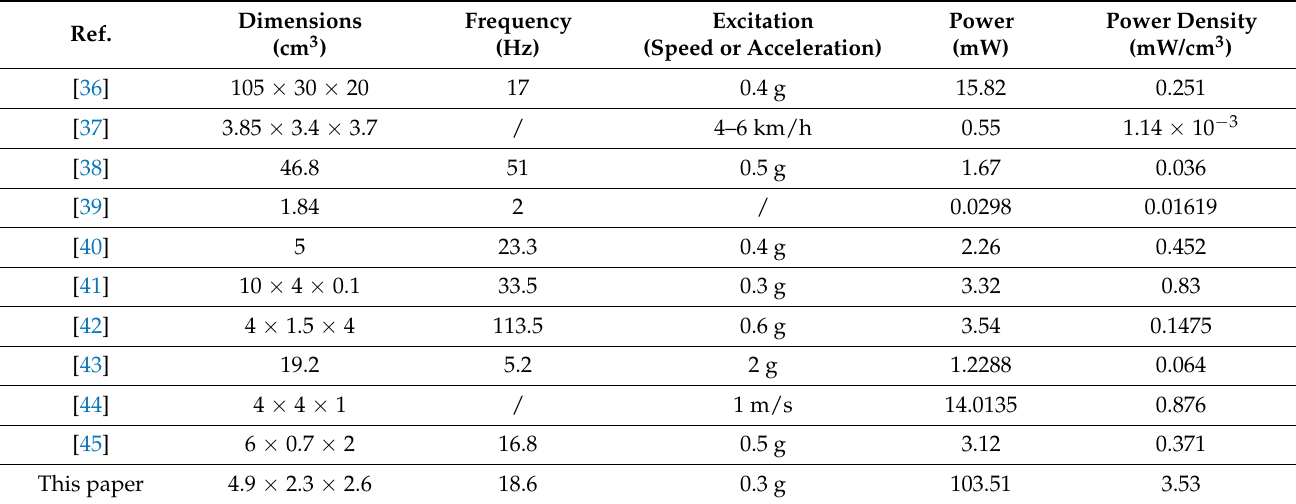
Table 2. The performance comparison of hybrid